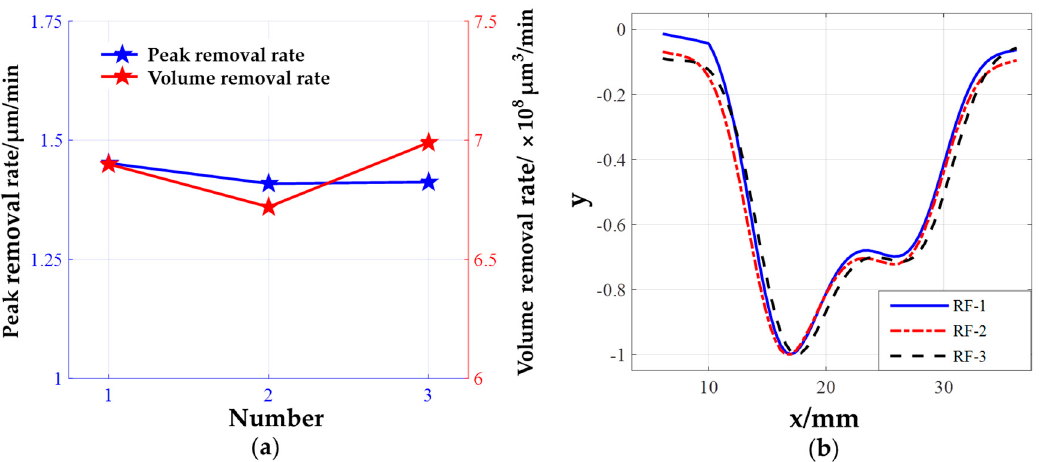
Figure 10. Removal function stability: ( a ) The variation curve of the peak and volume removal rate; ( b ) the normalized contour of different removal functions.